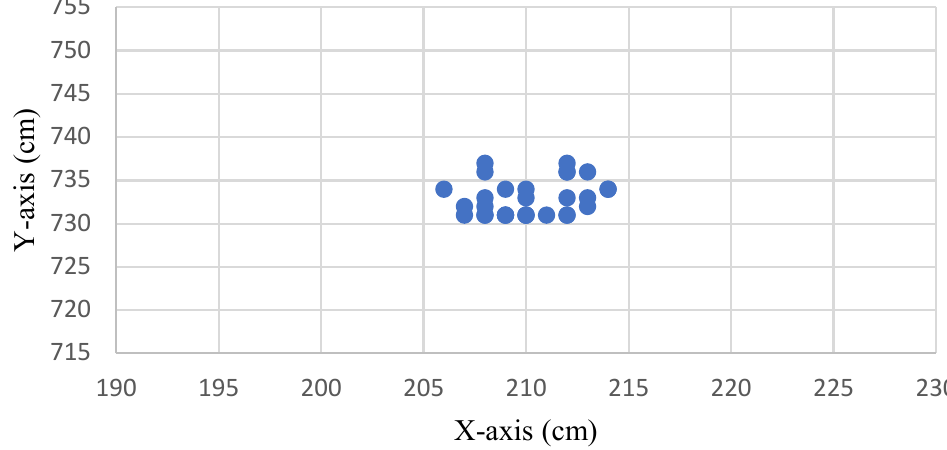
Figure 8. Distribution of the improved positioning points after being converged using the IAKF algorithm.